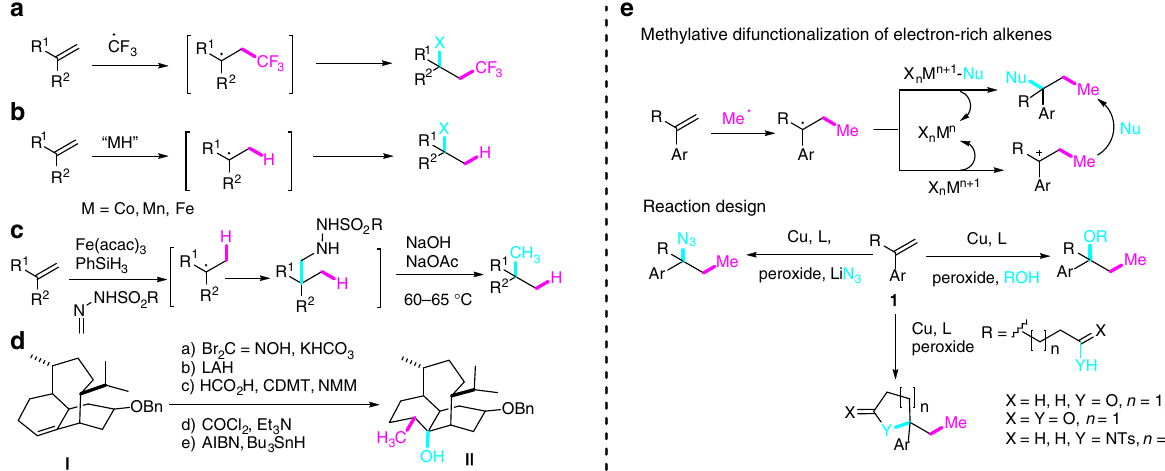
Fig. 1 Functionalization of unactivated alkenes. a Tri fl uoromethylative difunctionalization of alkenes; b hydrofunctionalization of alkenes. c hydromethylation of alkenes; d Example of 1,2-hydroxy methylation of alkene in natural product synthesis. Five steps were required to accomplish this transformation; e methylative difunctionalization of electron-rich alkenes: radical-metal mediated ligand transfer and radical-cation crossover processes. Abbreviations: Fe(acac) 3 iron (III) acetylacetonate; LAH lithium aluminum hydride; CDMT 2-chloro-4,6-dimethoxy-1,3,5-triazine; NMM N-methyl morpholine; AIBN